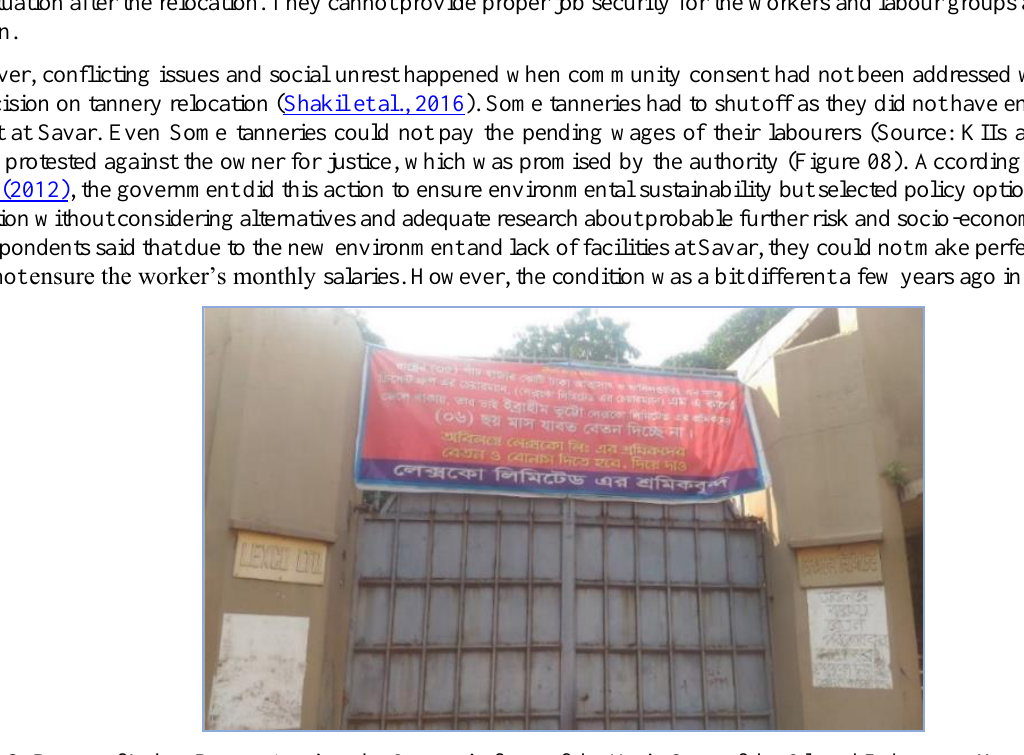
Figure 8: Poster of Labor Protest Against the Owner in front of the Main Gate of the Closed Industry at